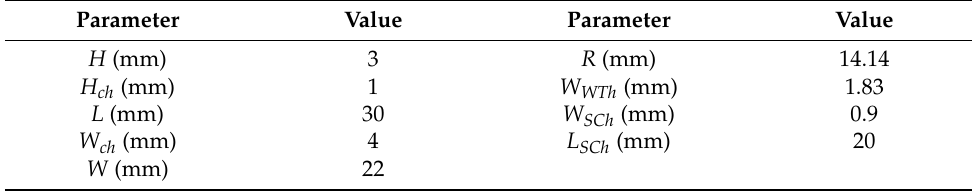
Table 3. Model specific dimensional parameters.